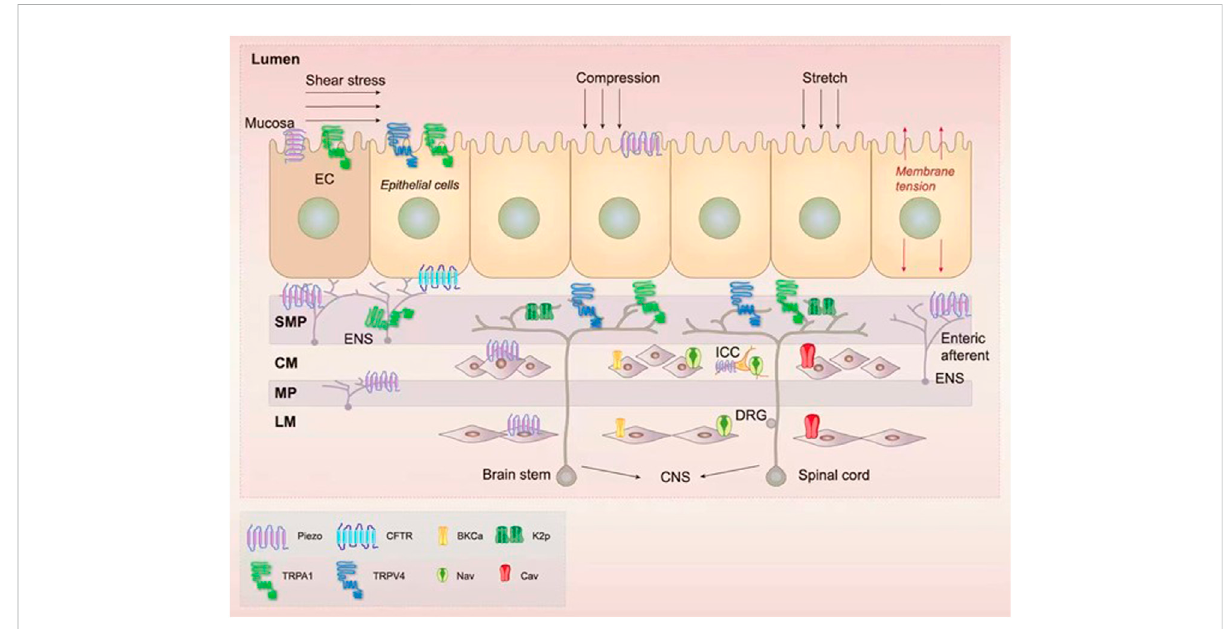
FIGURE 1 Expression of the mechanosensitive ion channels in the gastrointestinal (GI) tract. There are several mechanosensitive ion channels in the GI tract, namelytransientreceptor potential (TRP) (Brierley et al., 2008; Nozawa et al., 2009;Balemans et al., 2017;Alaimo and Rubert, 2019), Piezo (Bai et al., 2017; Mazzuoli-Weber et al., 2019), two-pore domain potassium (K2p) (Alcaino et al., 2017; Ma et al., 2018), voltage-gated ion channels (Farrugiaetal.,1999;Stregeetal.,2003b),large-conductanceCa 2+ -activatedK + (BKCa)channels(Ghattaetal.,2006;Singhetal.,2012),andthe cystic fi brosis transmembrane conductance regulator (CFTR) (Gadsby et al., 2006). These channels are located in many mechanosensitive intestinal cell types, namely enterochromaf fi n (EC) epithelial cells (Wang et al., 2017), interstitial cells of Cajal (ICCs) (Ranade et al., 2015), smooth muscle cells (SMCs)(Joshietal.,2021),intrinsicneurons[includingmyentericplexus(MP)andsubmucosalplexus(SMP)](Alcainoetal.,2017),andextrinsicenteric neurons [composed of neurons from the central nervous system (CNS)] (Alcaino et al., 2017). In the intestinal lumen, a variety of mechanical forces such as shear stress, compression, stretch, and membrane tension can be sensed by mechanosensitive ion channels (Hamill and Martinac, 2001; Alcaino et al.,